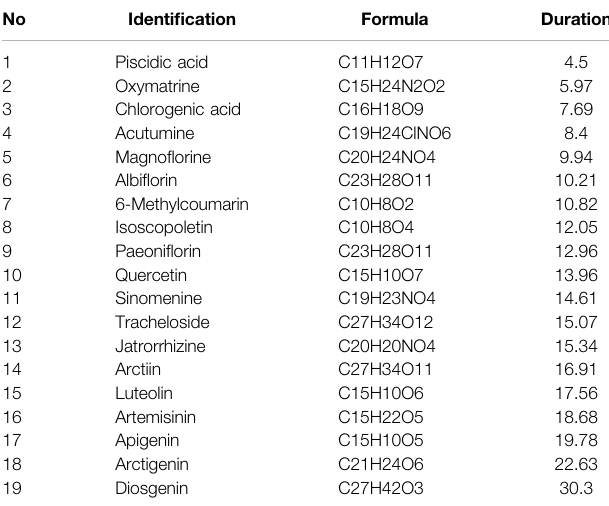
TABLE 1 | Chemical components identi fi ed from LTD by